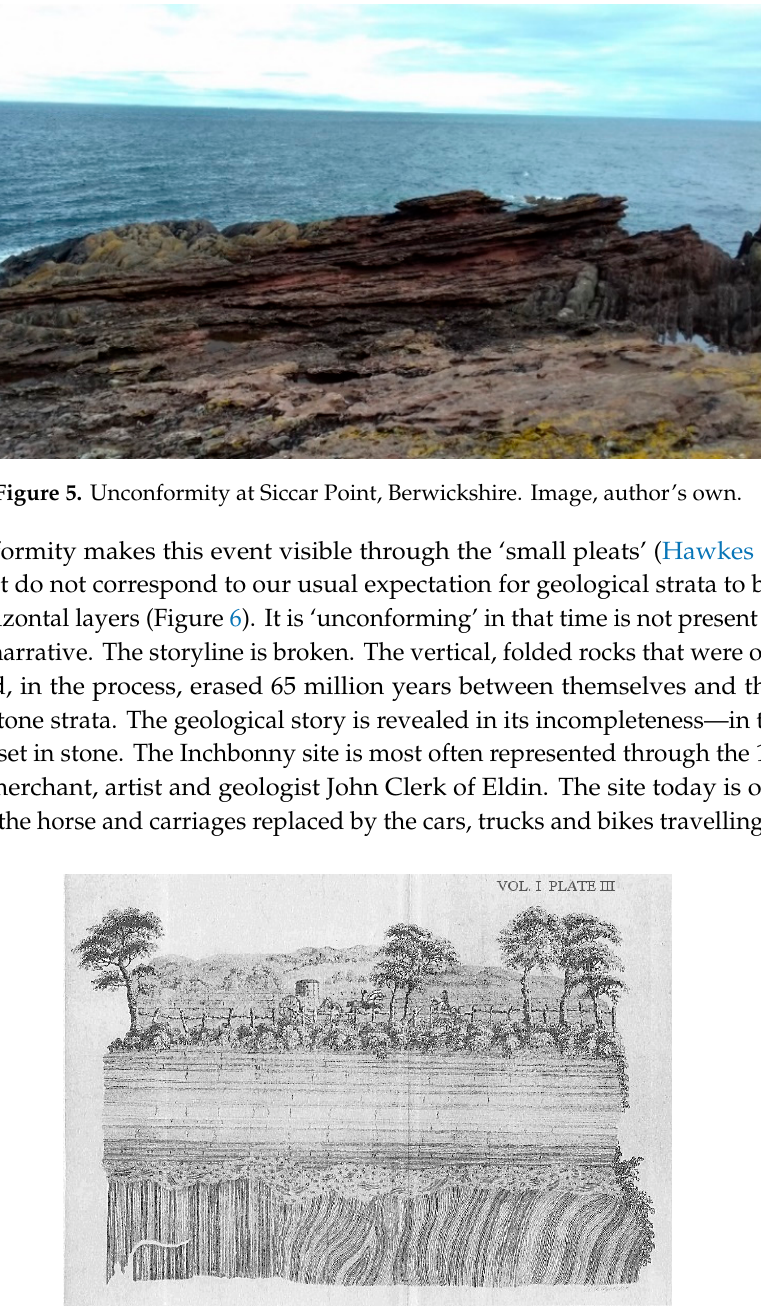
Figure 6. Engraving of the Unconformity at Inchbonny, near Jedburgh, by Scottish merchant, artist and geologist John Clerk of Eldin. In ‘Theory of the Earth’ by James Hutton. Image courtesy of © British Library Board, General Reference Collection 1651/958. 32.i.8-9.